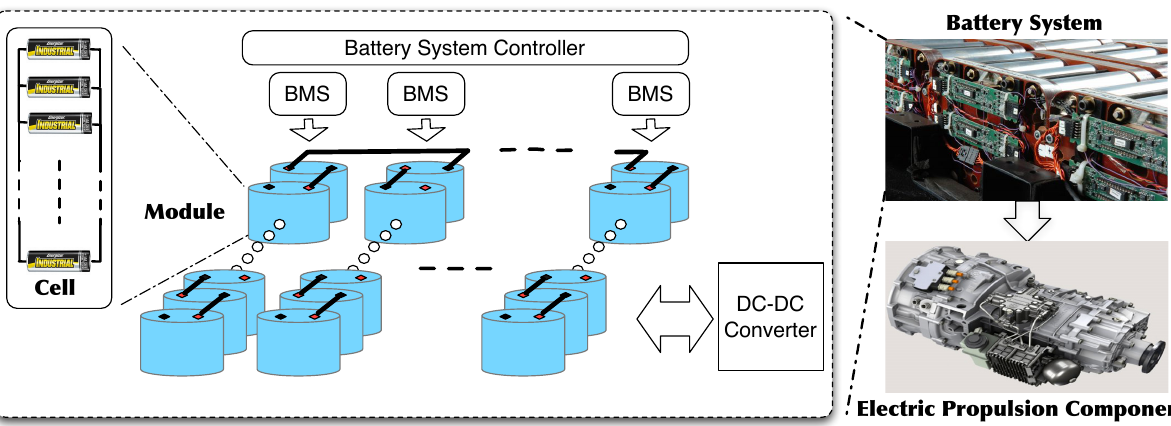
Figure 1. Battery system architecture for electric-drive